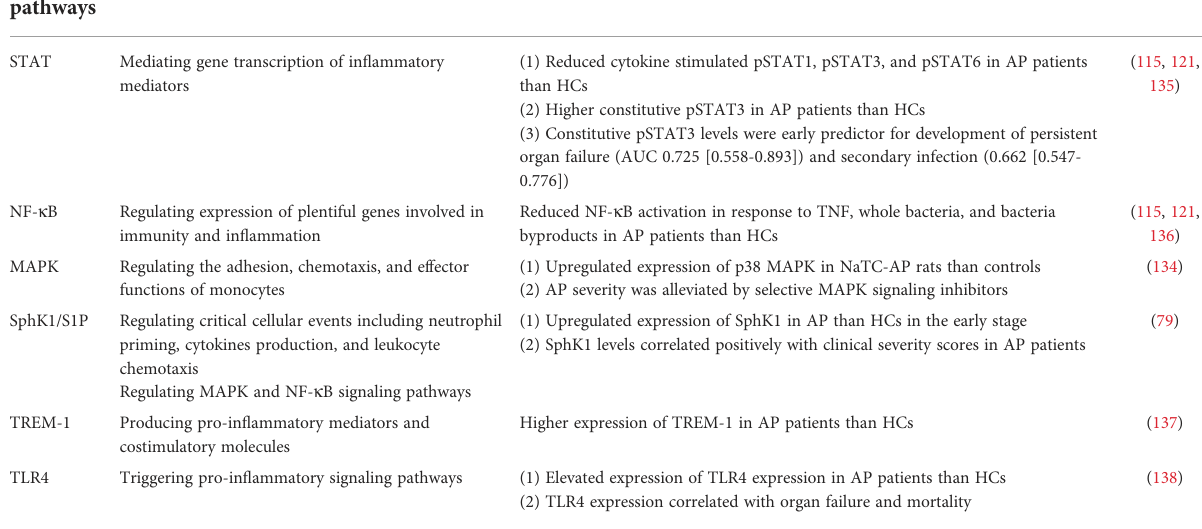
TABLE 2 Aberrant signaling pro fi les of monocytes in acute